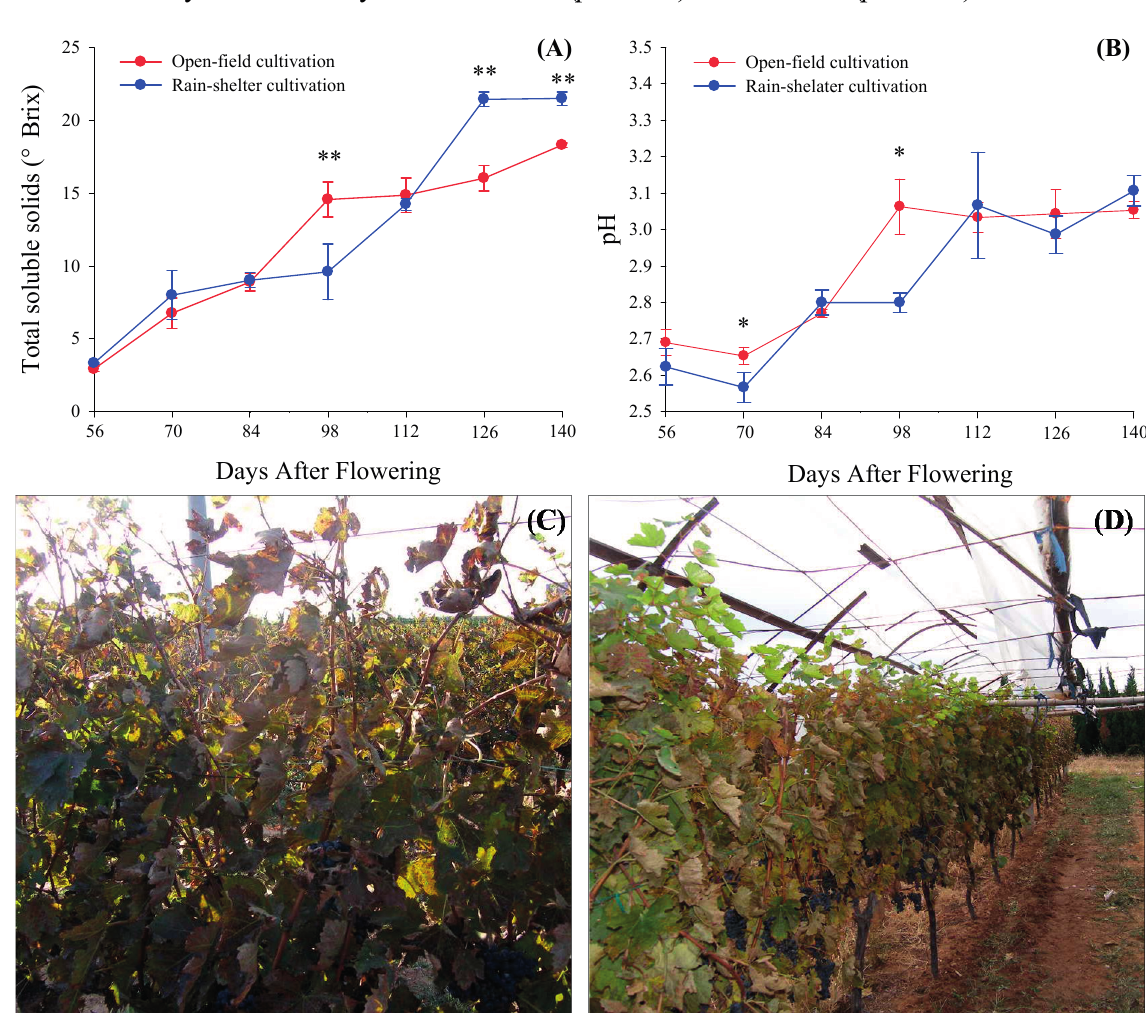
Figure 2. The variations of total soluble solids (A) and pH (B) of grape juice between vines grown under open-field cultivation and rain-shelter cultivation; and canopies of vines grown under open-field cultivation (C) and rain-shelter cultivation (D) at commercial harvest. Data are mean ± standard deviation. The symbol “**” or “*” above each set of columns represents that there are significant difference between rain-shelter cultivation and